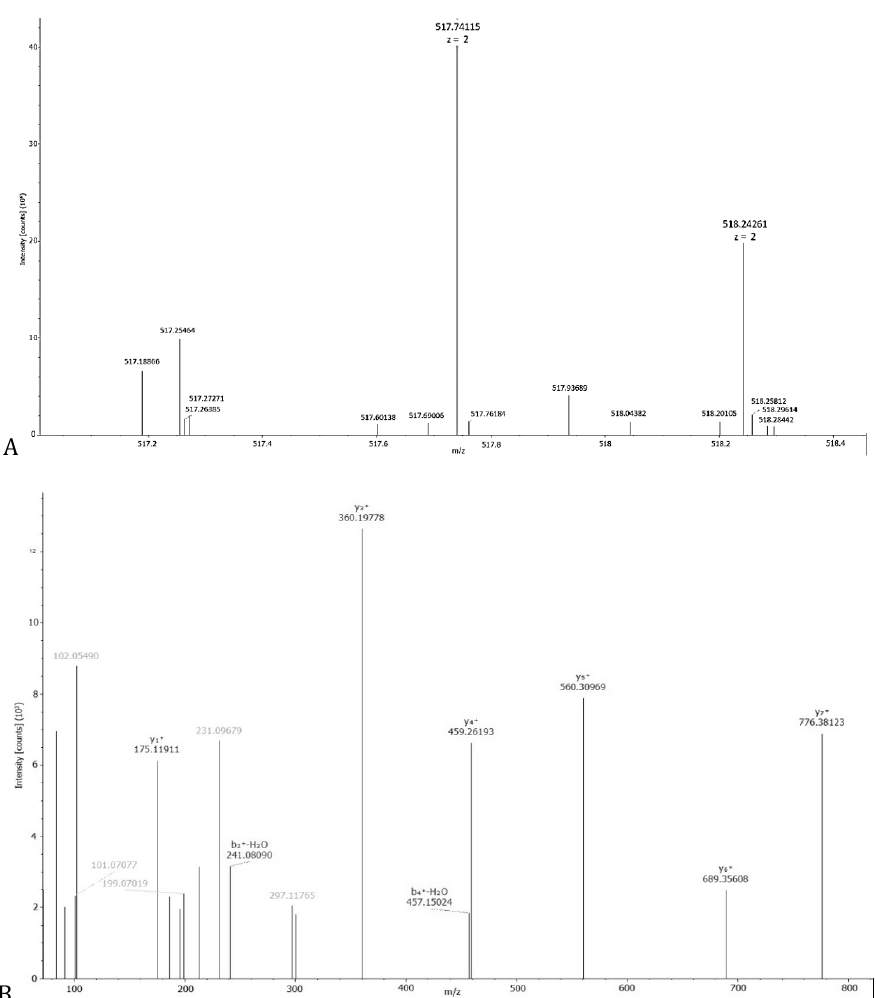
Figure 3. MS spectra of peptide number 1 of the pH 4 fraction of R. communis seed protein hydrolysate. MS 1 identifies the isotopic pattern of the peptide ion (a), whereas MS 2 identifies the b + and y + ions from the peptide fragmentation data